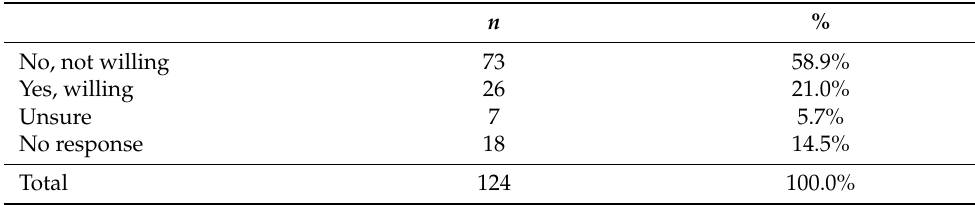
Table 2. Willingness of older adult participants to use fully autonomous vehicle ride sharing, Barriers and Facilitators of Older Adults’ Use of Ride Share Services Study, 2019, n =